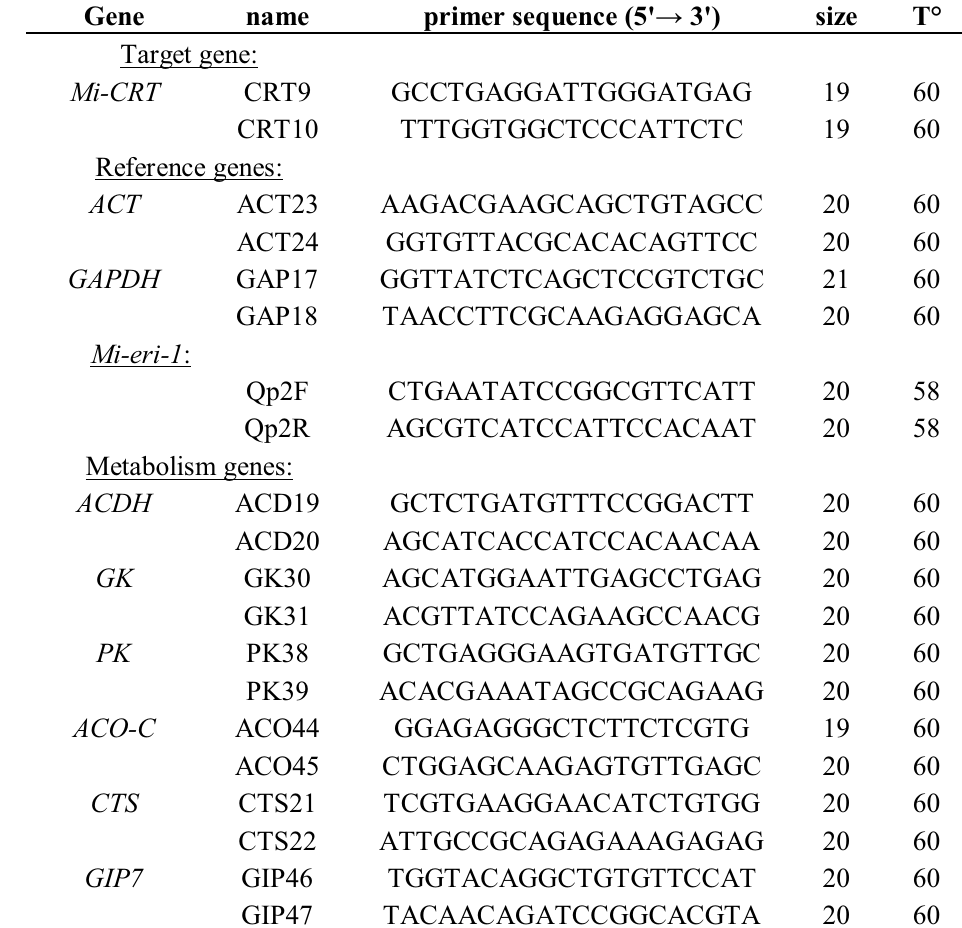
Table 2. Sequence of the oligonucleotides used for Reverse Transcriptions and quantitative